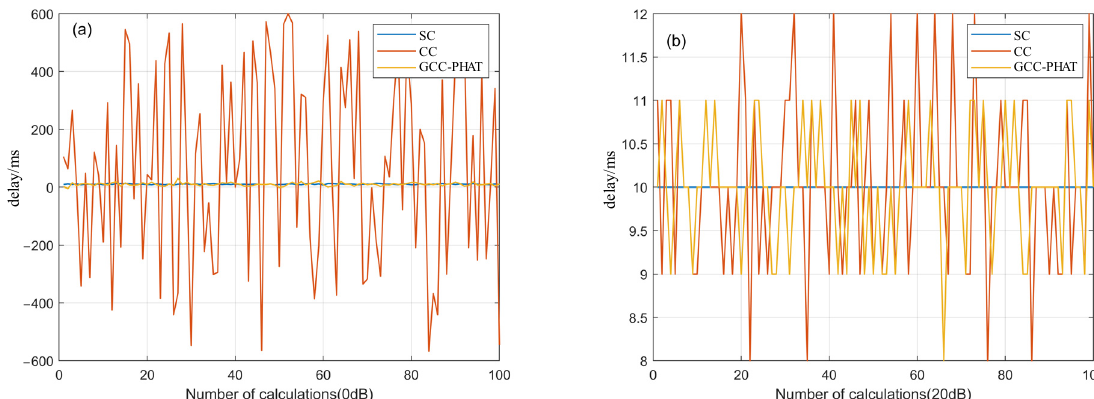
Figure 4. Time delay values calculated by three methods when the SNR is 0 dB ( a ) and 20 dB ( b ).